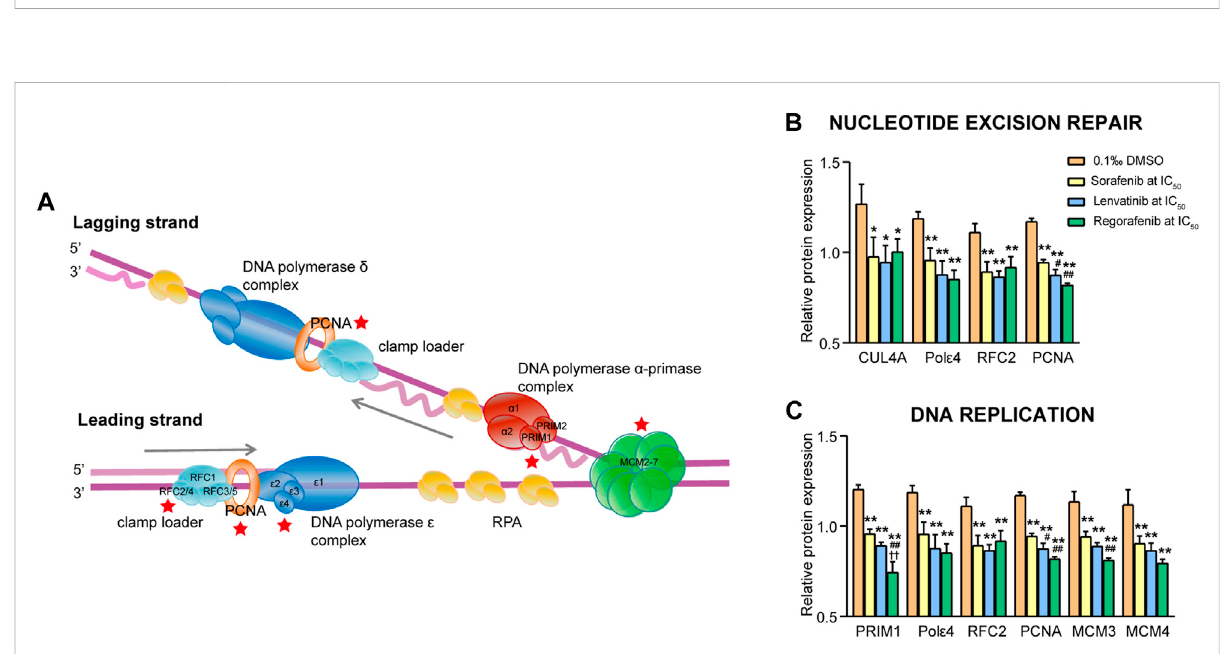
FIGURE 10 Commonly downregulated proteins involved in the nucleotide excision repair and DNA replication pathway (A) and their relative expression ( B and C) in Huh-7 cells treated by 72 h incubation with respective sorafenib, lenvatinib and regorafenib. Each bar presents mean ± SD ( n = 3). The * p < 0.05 and ** p < 0.01 versus DMSO; # p < 0.05 and ## p < 0.01 versus sorafenib; †† p < 0.01 versus lenvatinib. Star symbol in red color indicating the downregulation of the